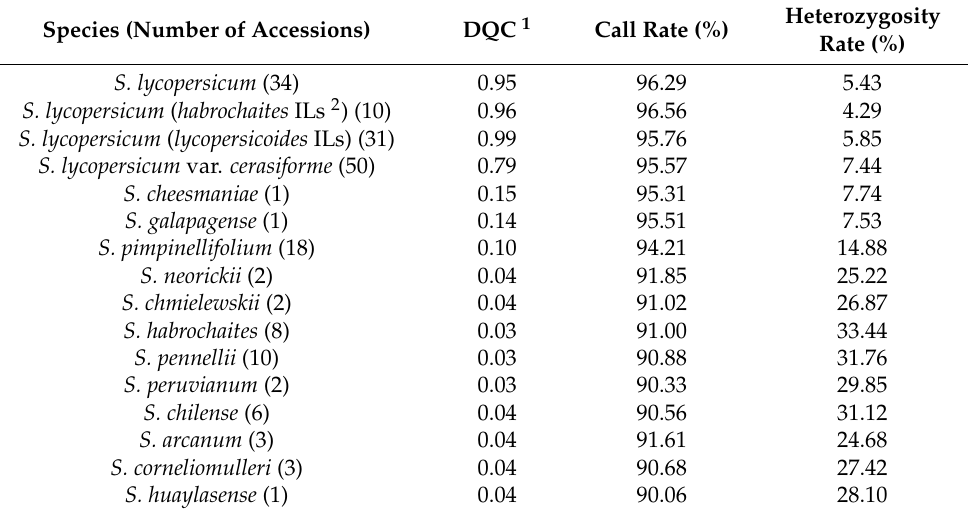
Table 3. The Dish QC (DQC), call rate, and heterozygosity rate of single nucleotide polymorphisms obtained upon genotyping of 182 tomato accessions using the Axiom ® Tomato Genotyping Array. Species (Number of Accessions) DQC 1 Call Rate (%)